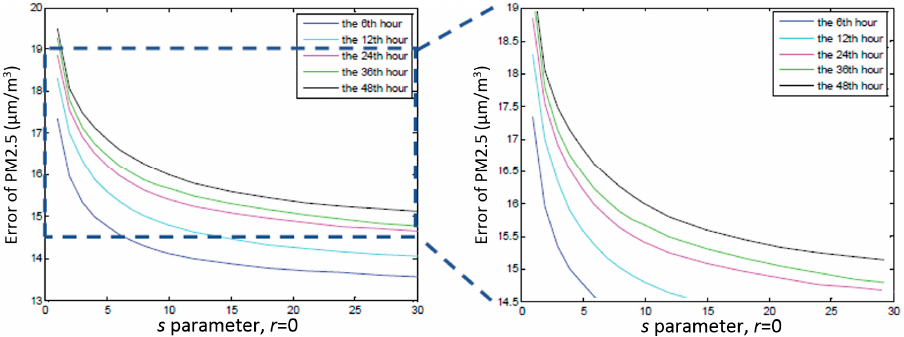
Figure 9. The impact on PM2.5 error of parameter s on PM2.5 value forecast.